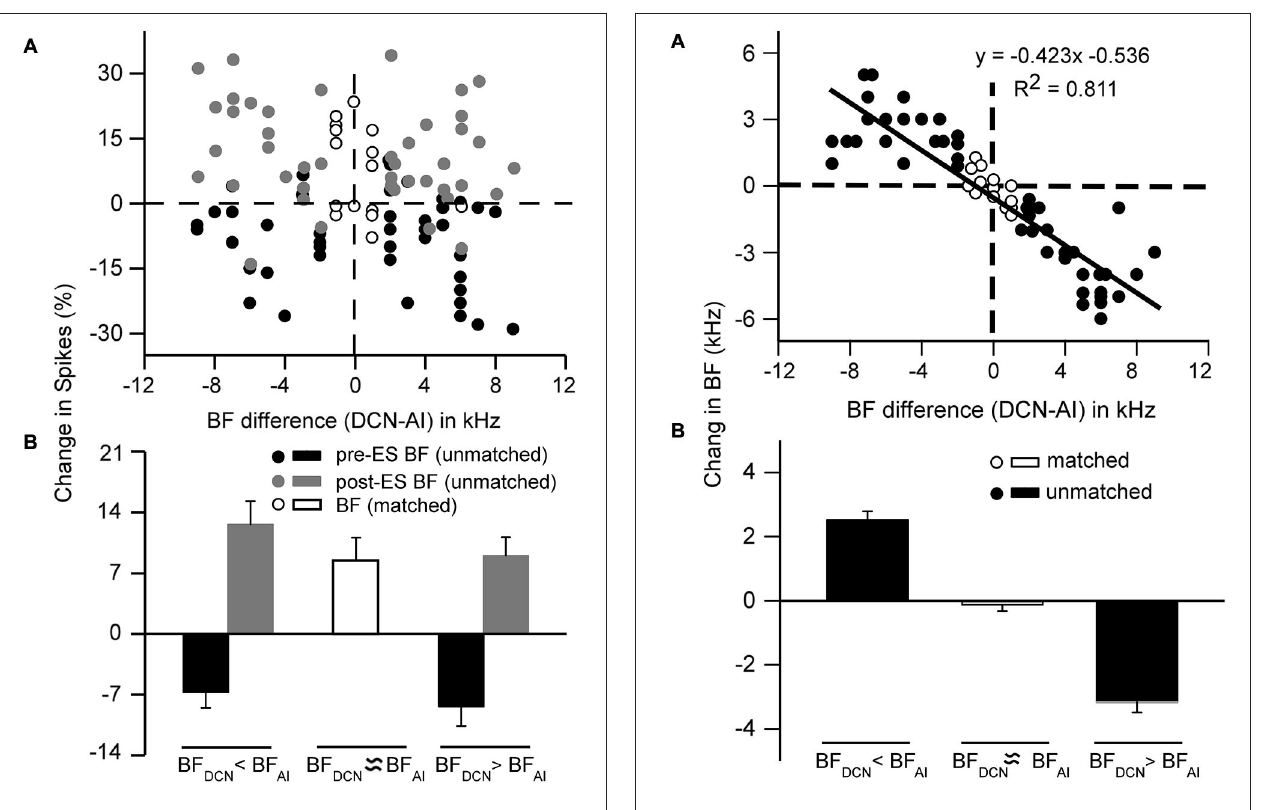
FIGURE 3 | Frequency-specific changes in the auditory responses (spikes) of DCN neurons after contralateral cortical stimulation . (A) The degree of change was different between the matched and unmatched DCN neurons. Filled black circles indicate responses at pre-ES BFs (Control); filled gray circles indicate responses at post-ES BFs, open circles indicate responses of neurons with matched BF. (B) The averaged response change after cortical stimulation. Filled black bars show averaged responses at pre-ES BFs (control); filled gray bars show averaged responses at post-ES BFs, open bar shows averaged response of neurons with matched BF. The error bars represent the SEM.